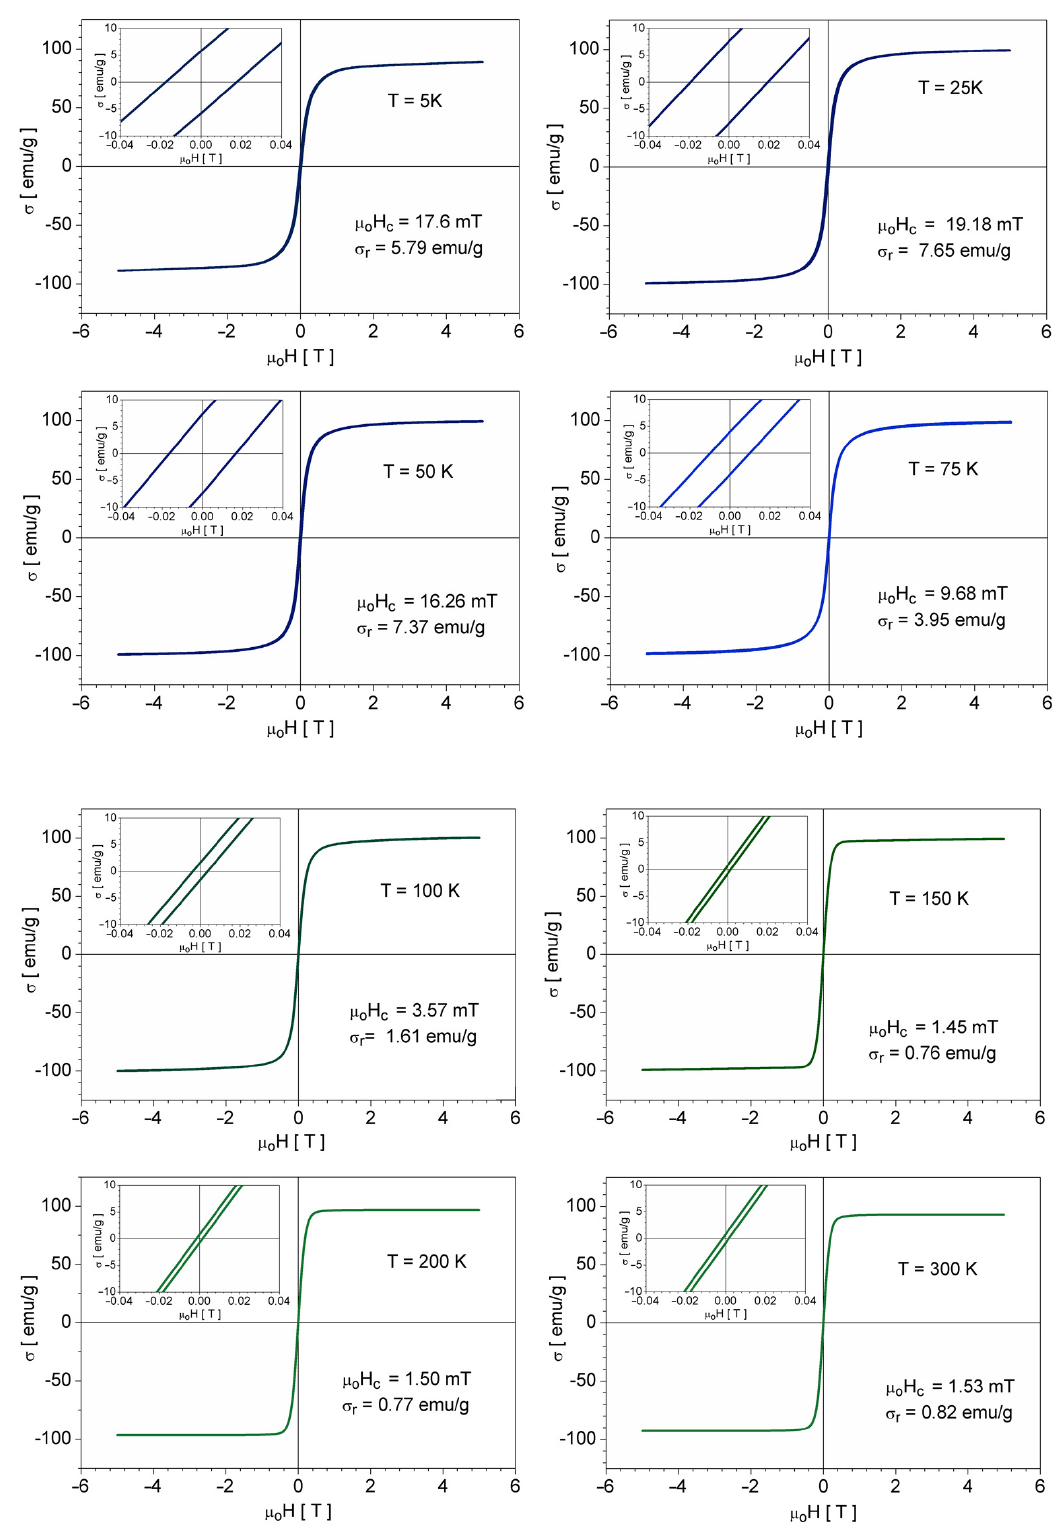
Figure 5. Magnetic hysteresis loops are recorded at temperatures between 5 K and 300 K.